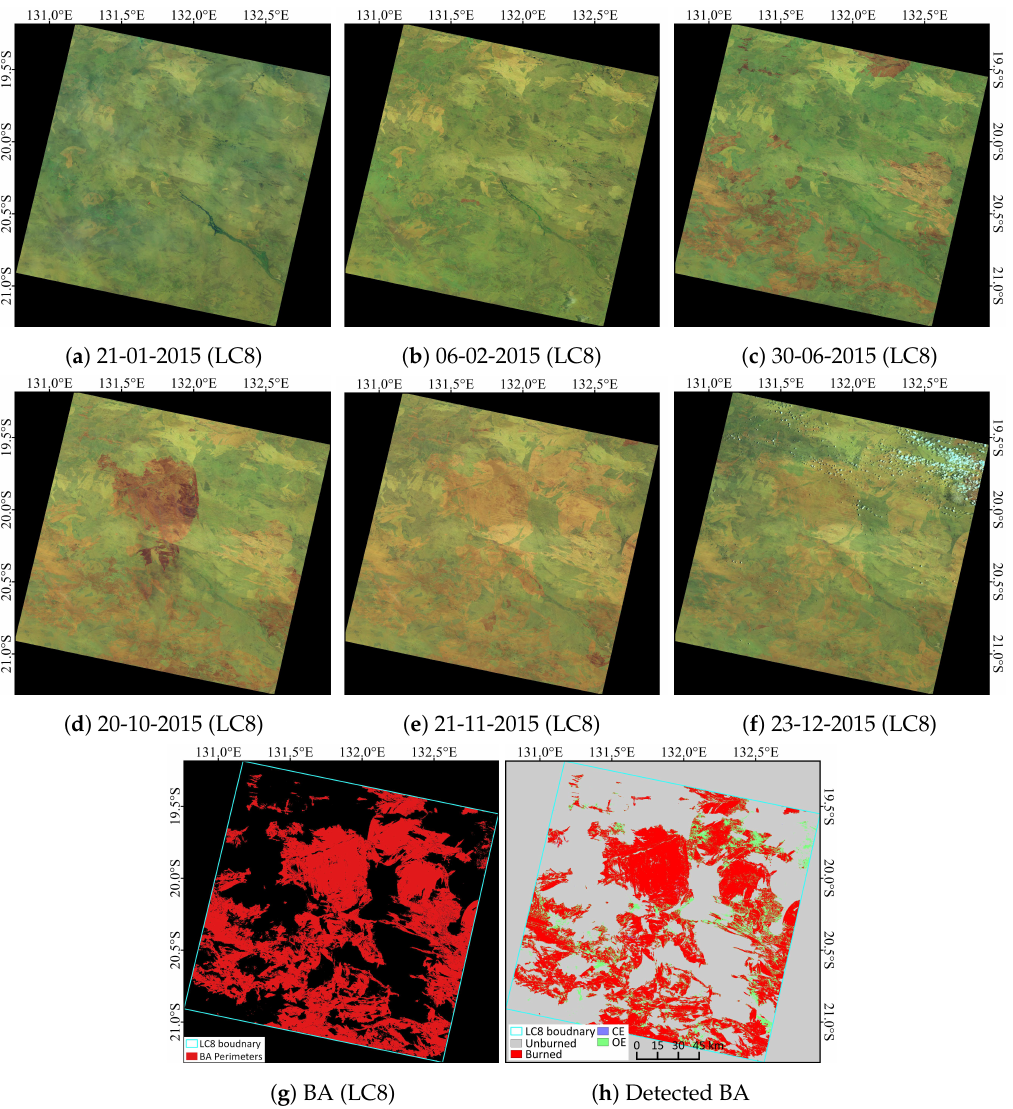
Figure A4. Example of validation using Landsat-8 images (path/row: 104/074) in Australia. ( a – f ) show the Landsat-8 images used to generate the reference map, displayed in false color composition (red: SWIR2 band, green: NIR band, and blue: green band); ( g ) is the reference BA map generated from Landsat-8 images; and ( h ) is the detected BA by proposed method with CE and